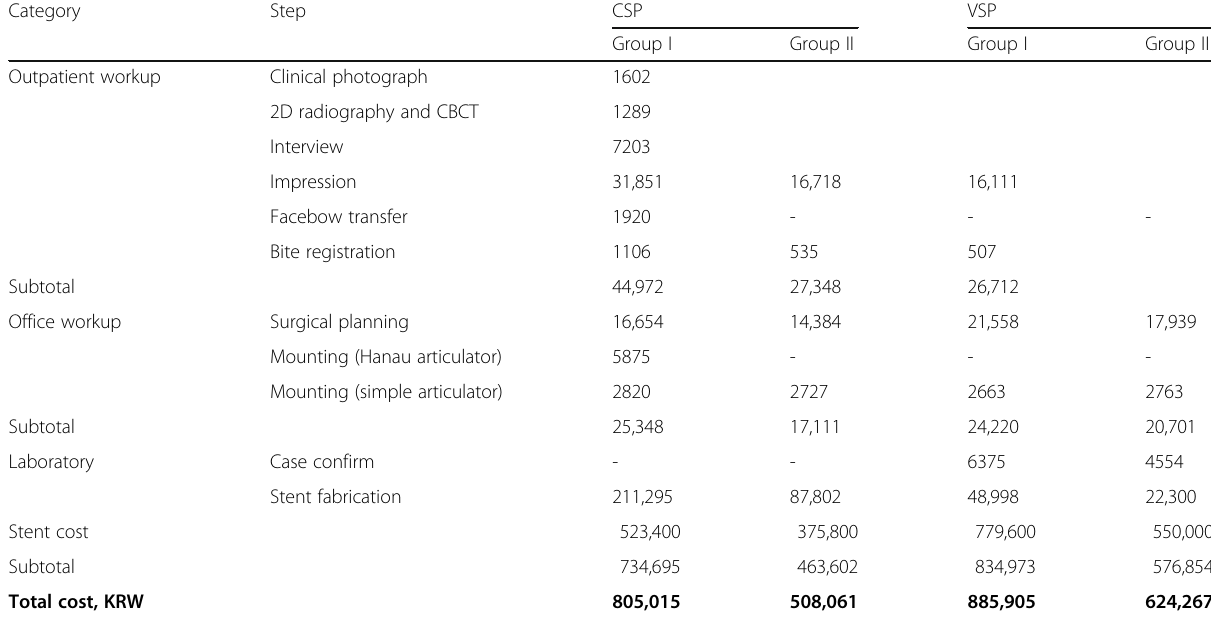
Table 4 Total cost for each group in CSP and VSP Category